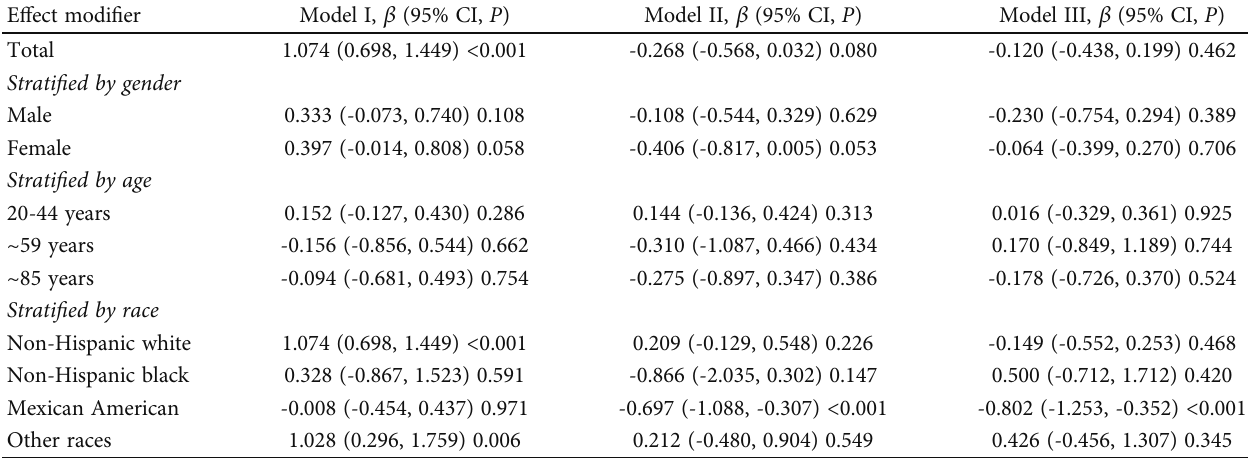
Table 2: Correlation of H. pylori IgG seropositive and plasma Hcy